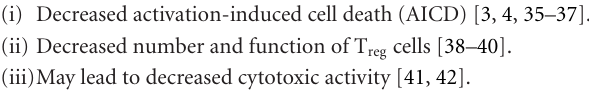
Table 1: Consequences of decreased IL-2 production in SLE